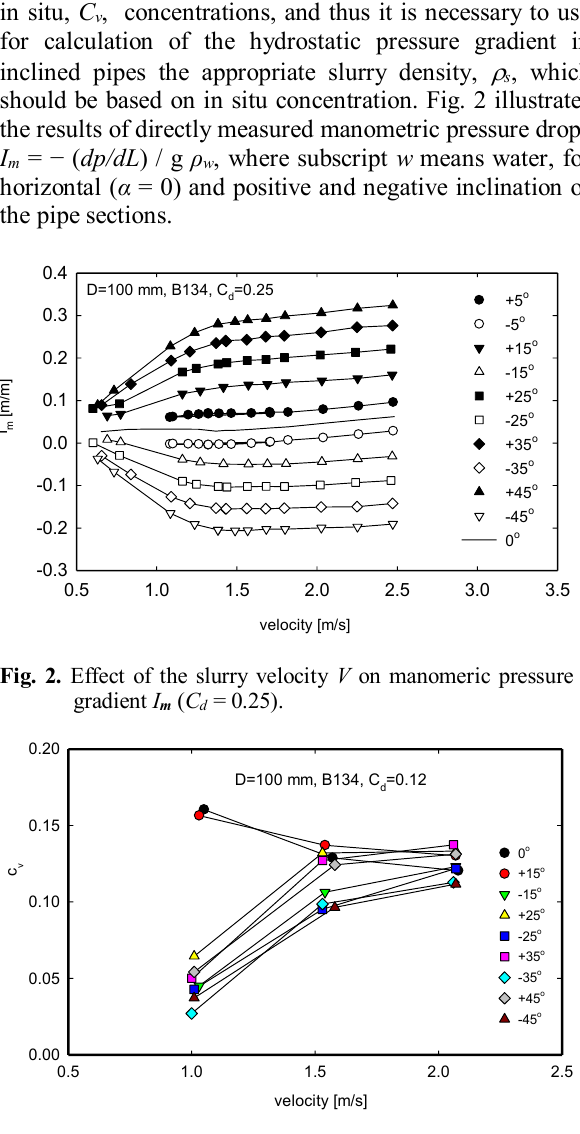
Fig. 3. Effect of the slurry velocity V on mean in situ concentration C v ( C d = 0.12)